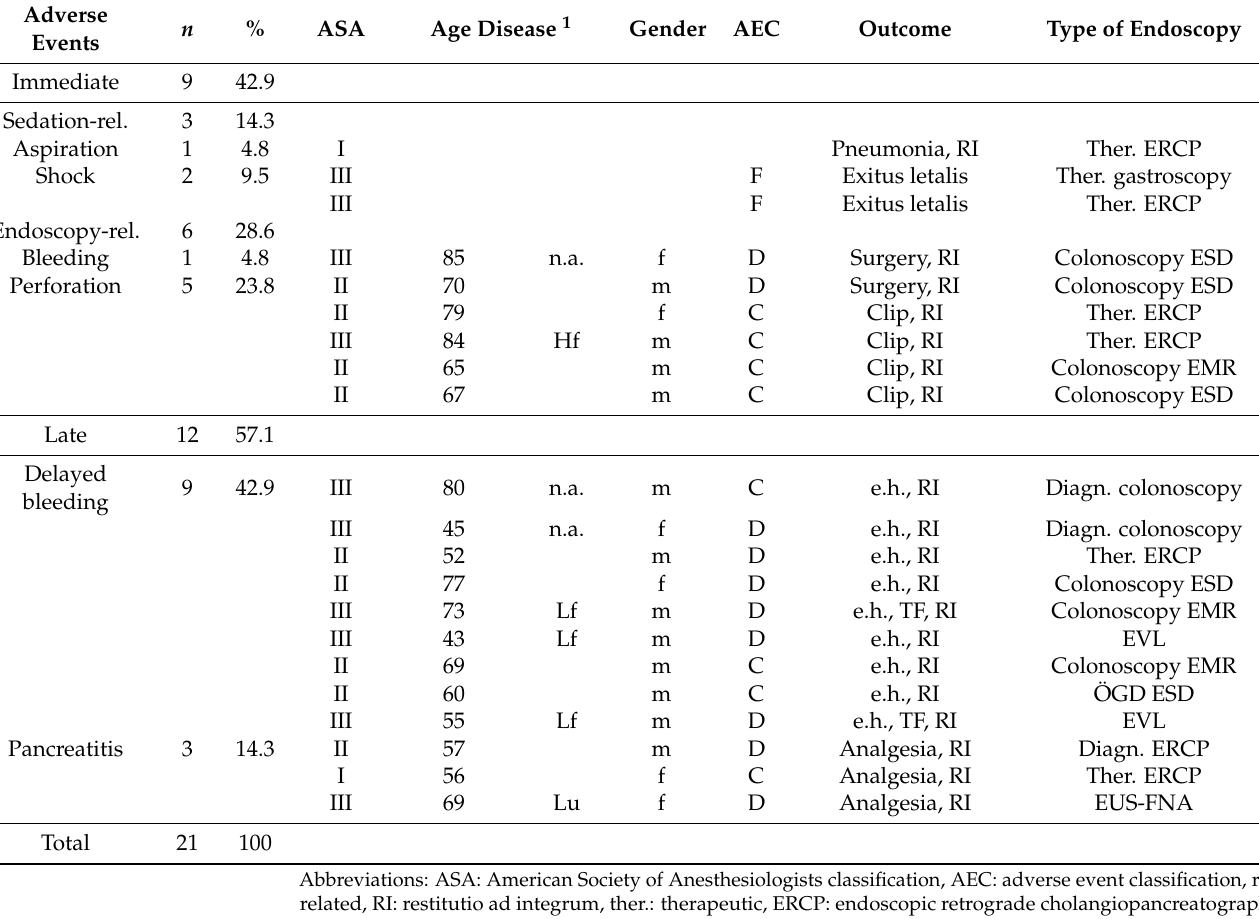
Table 4. Major AEs, risk profiles, and